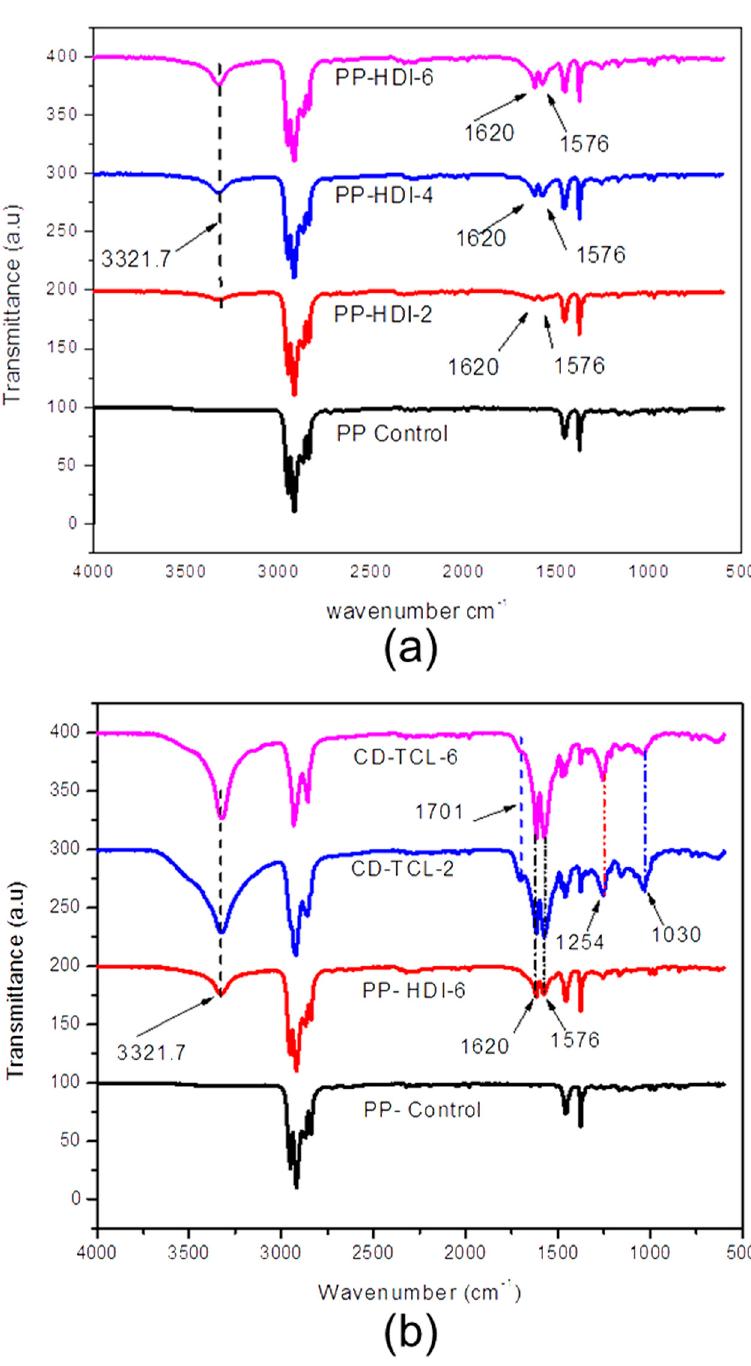
Figure 5. FTIR (ATR) spectra; ( a ) PP-HDI grafted samples (PP-HDI-2), (PP-HDI-4) and PP-HDI-6; and ( b ) PP control, PP-HDI-6-grafted, and triclosan-loaded (CD-TCL-2 and CD-TCL-6) samples.